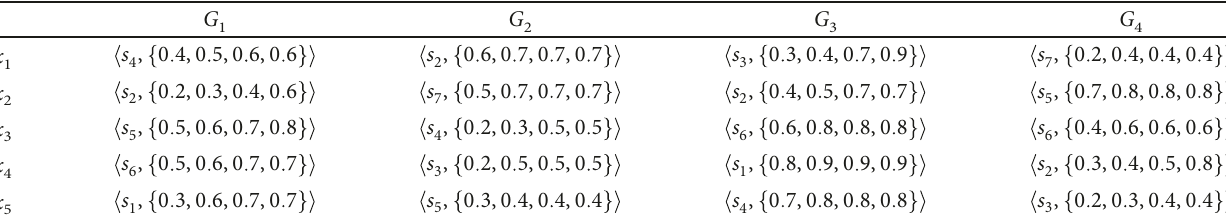
Table 2: Normalized hesitant fuzzy linguistic decision matrix.